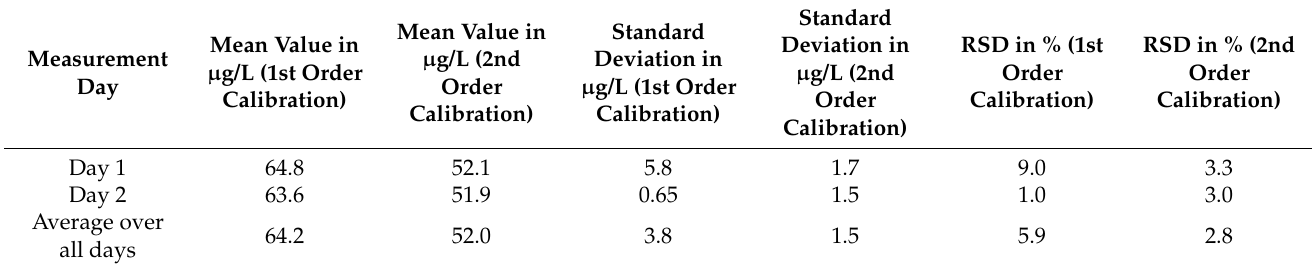
Table 6. Mean values, standard deviations, and relative standard deviations (RSD) as calculated from the voltammetric investigation of test samples containing 50.0 µ g/L platinum measured with a bismuth film on screen-printed